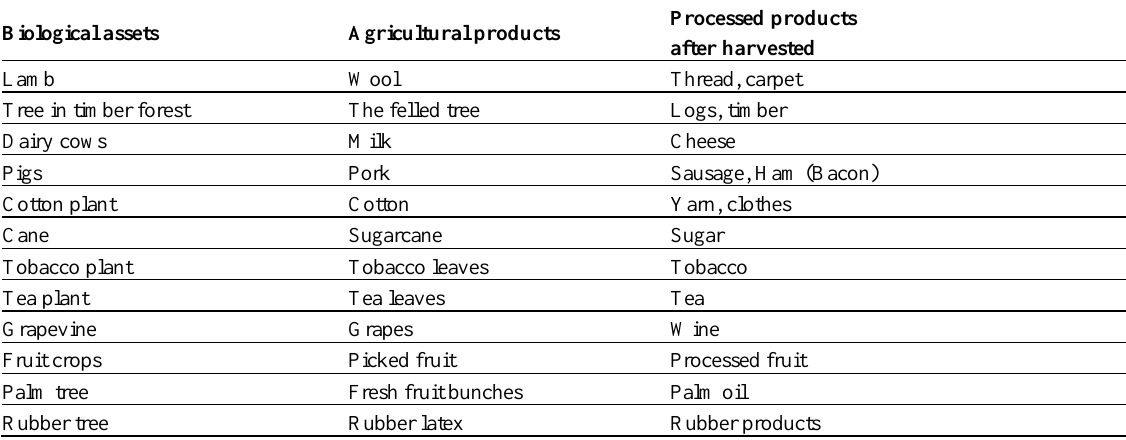
Table 1 : Examples of biological assets, agricultural products and processed products after